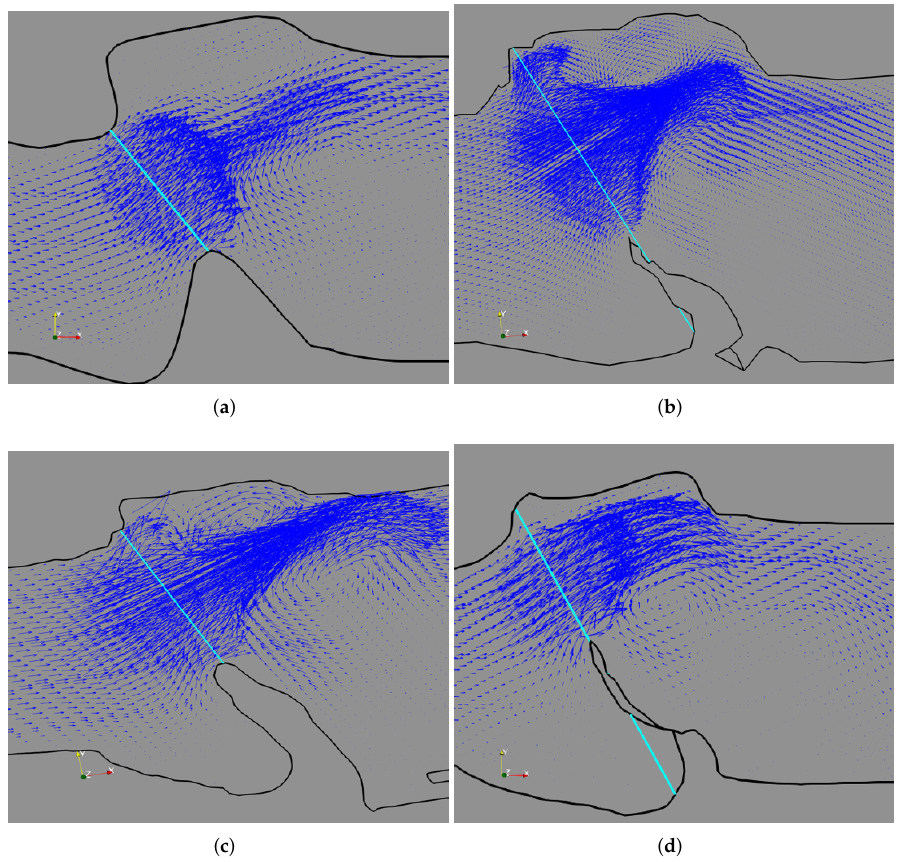
Figure 10. Flow pattern in the supraglottal region and the anterior, posterior vortices in Samples 1, 2, 4, and 5 in ( a – d ) respectively. The vocal fold is at an open